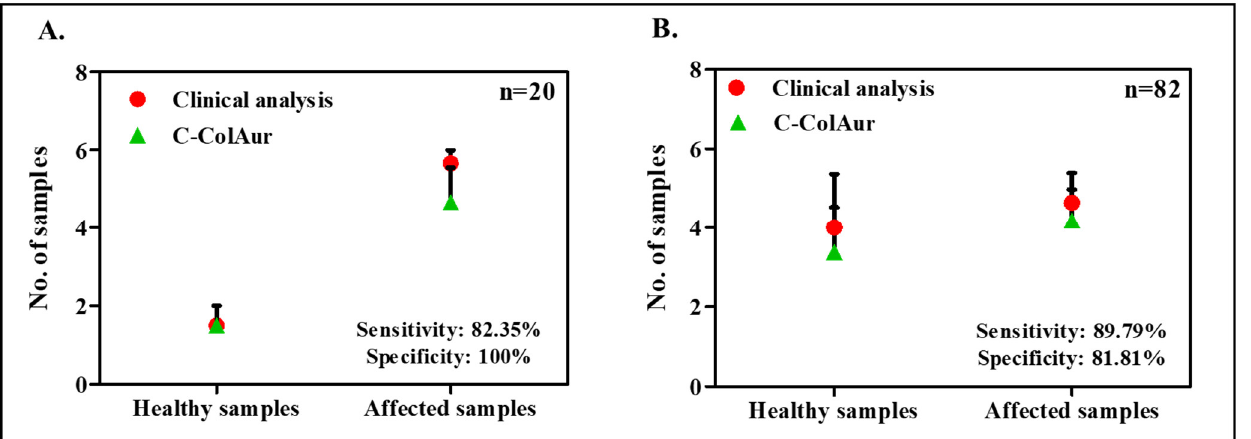
Figure 2. Comparison of C -Col Au r with clinical analysis for ( A ) new samples ( n = 20) and ( B ) total samples ( n = 82).